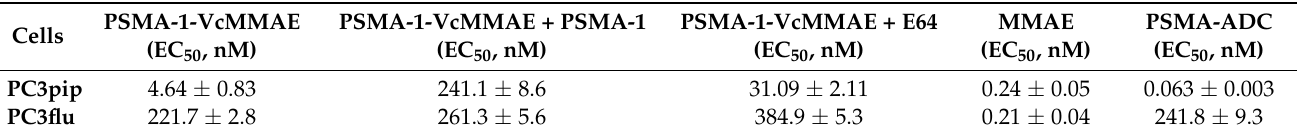
Table 1. In vitro cytotoxicity of PSMA-1-MMAE, MMAE, and PSMA-ADC.